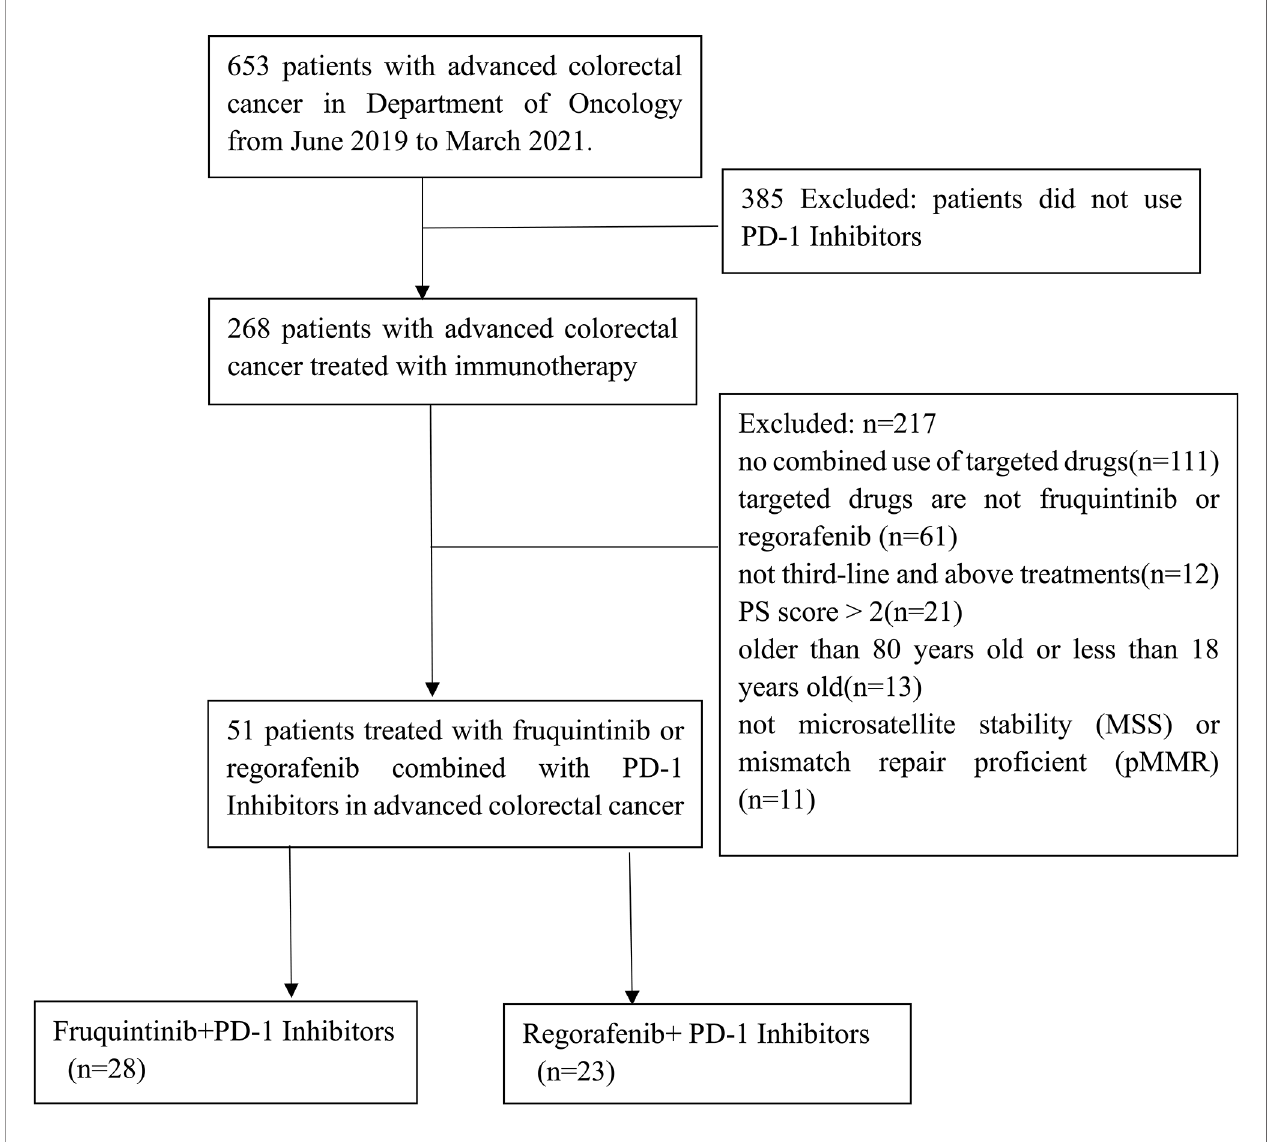
FIGURE 1 | Flowchart of the patient